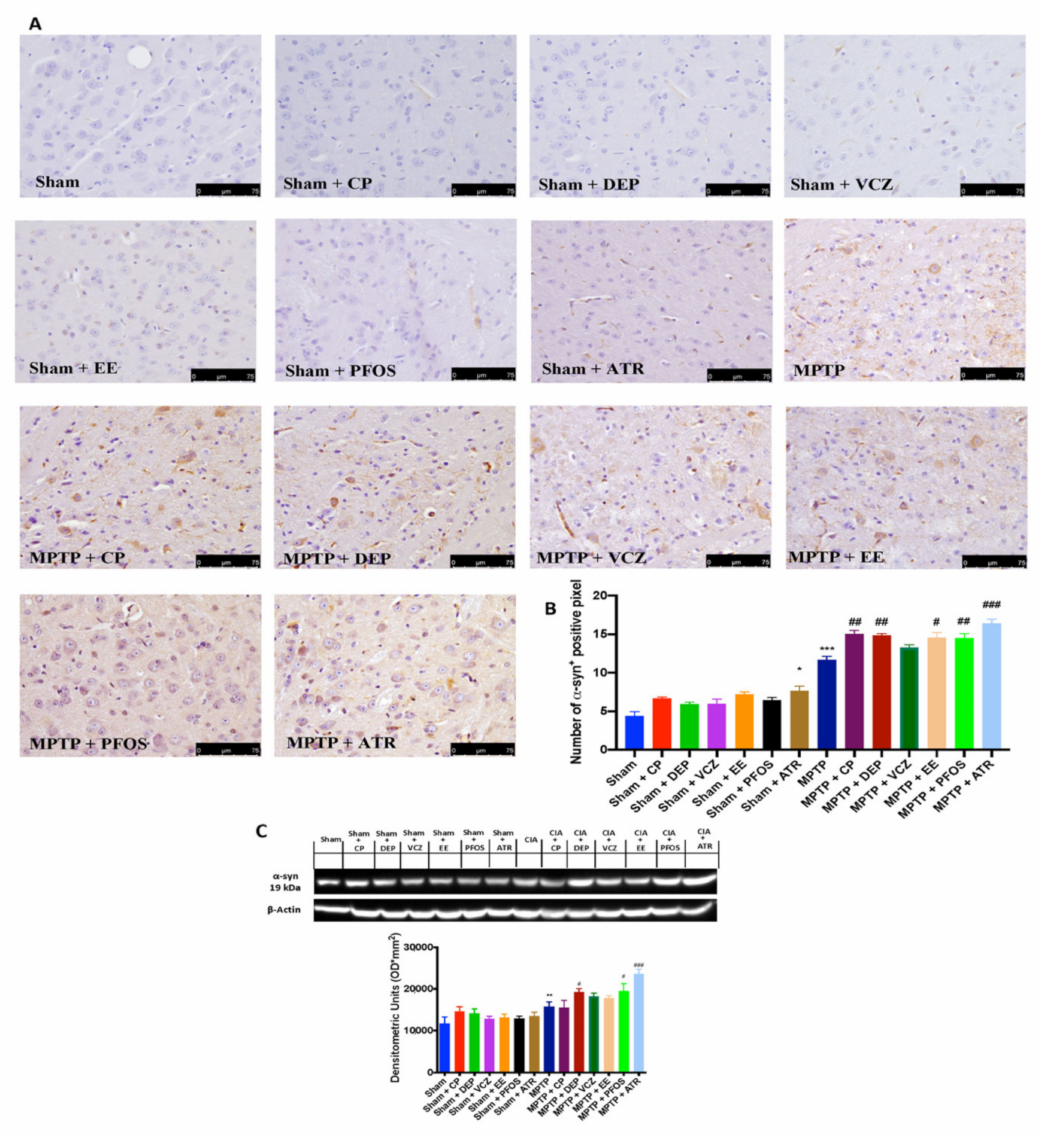
Figure 3. Immunohistochemical evaluation for α -syn expression ( A ). Graphical quantification of α -syn expression ( B ). Western blot and densitometric analysis of α -syn ( C ). A 40 × magnification is shown (75- µ m scale bar). A demonstrative blot of lysates with a densitometric analysis for all animals is shown. Data are expressed as the mean ± SEM of N = 6 mice/group. * p < 0.05 vs. sham; ** p < 0.01 vs. sham; *** p < 0.001 vs. sham; # p < 0.05 vs. MPTP; ## p < 0.01 vs. MPTP; ### p < 0.001 vs.